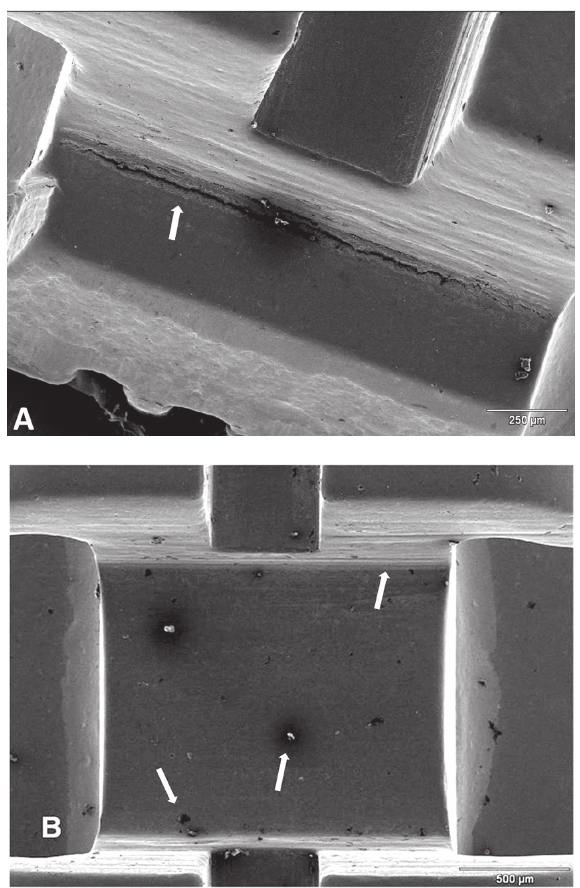
Figure 3- Cleft found on the external surface of the base of the tie-wing on a new bracket with 75x magnification (A). Marks of machining, corrosion cavities (which appear as dark spots), some filled with impurities; 15x magnification (B) as shiny white spots in the SeM images (Figure 3A). There were also clefts of different sizes on the external surface of the bracket wings base (Figure